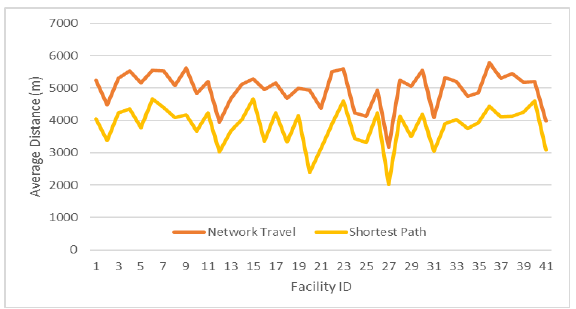
Figure 4 Average travel distance for the facilities